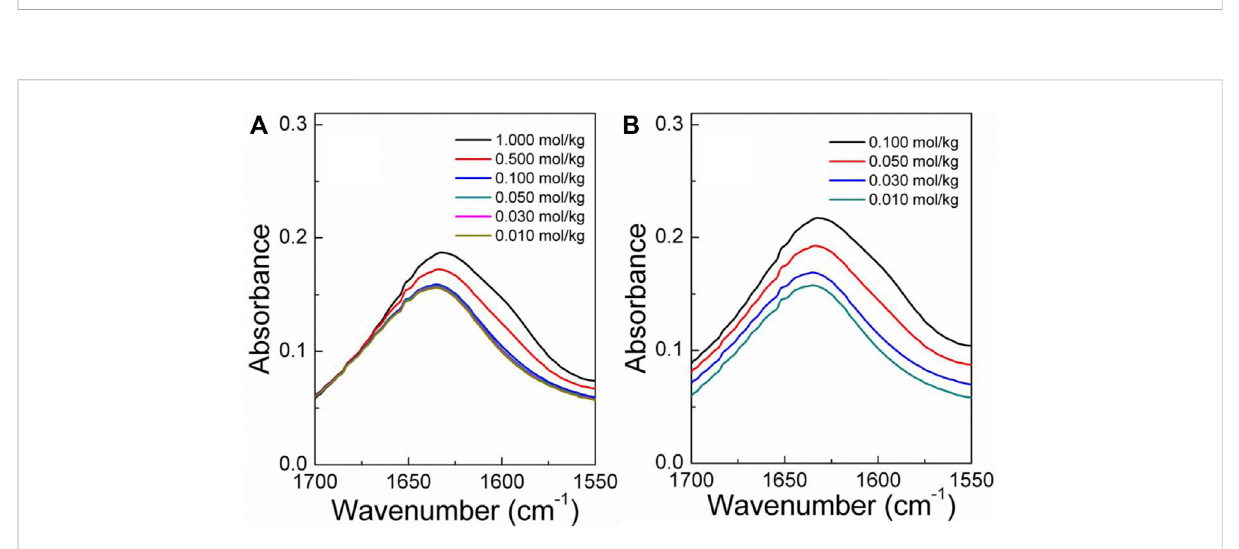
FIGURE 8 Infrared spectra of the L -serine aqueous solution in the range of v (C=O). (A) Actual curve. (B) Elevated curve of (A)